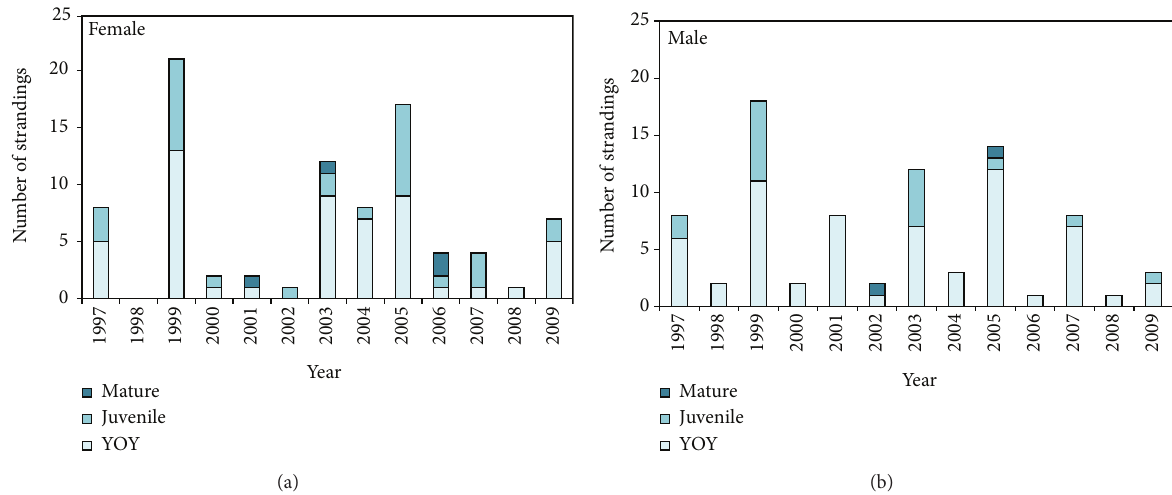
Figure 5: Age class categories by sex (female = 87; male = 82) of harbor porpoise strandings in North Carolina during 1997–2009: Young- of-Year (YOY) ( ≤ 118cm); juvenile (females = 119–142cm; males = 119–134cm); mature (females ≥ 143cm; males ≥ 135 cm). Strandings of unknown sex or for which lengths were estimated were excluded.